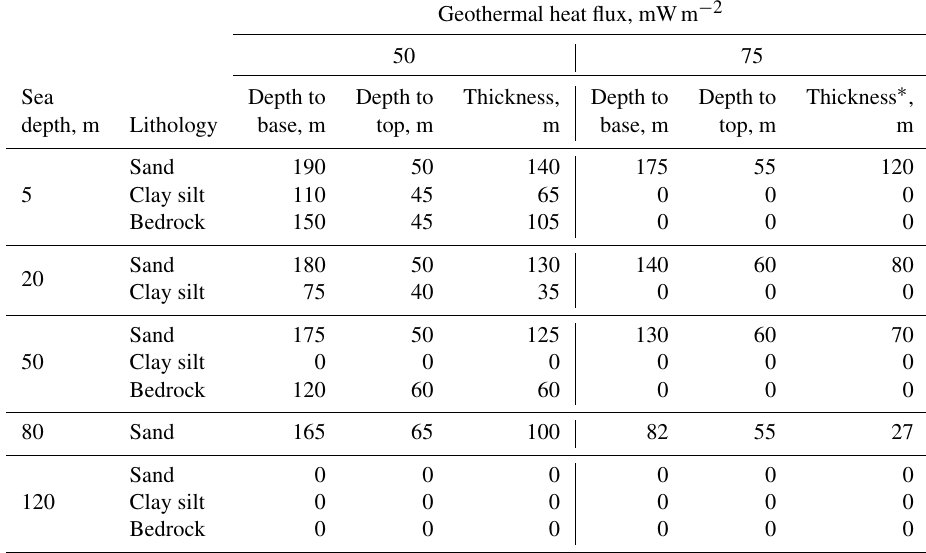
Table 2. Modeling results for depths to permafrost top and base and permafrost thickness for a uniform lithology, SW area.